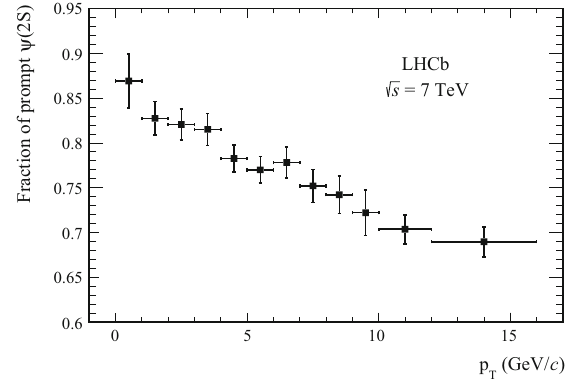
Fig. 4 Fraction of prompt ψ( 2 S ) , f p , as a function of p T . The error bars include statistical and systematic uncertainties added in quadrature